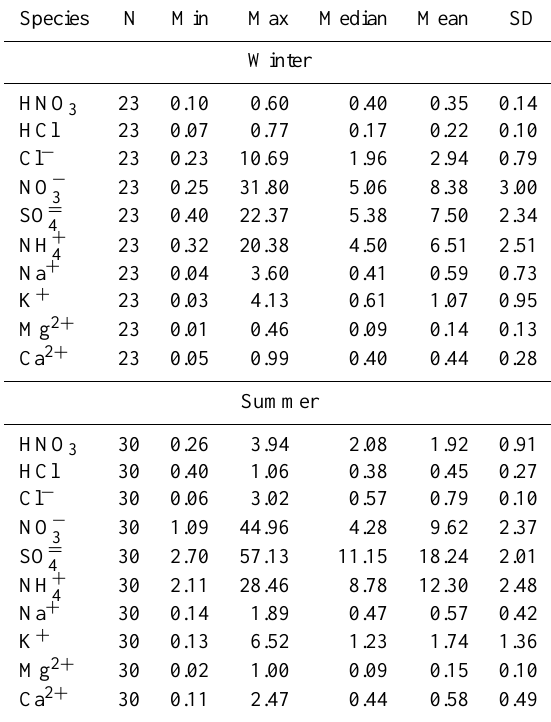
Table 2. Statistics of concentrations (µgm − 3 ) of some gas species and ions in PM 2 . 5 , measured on a 24-h basis, during the winter and the summer periods at